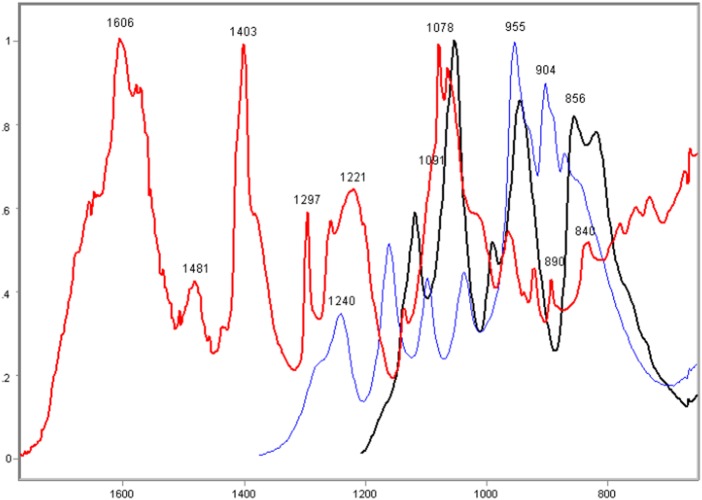
FT-IR spectral profile of calf thymus DNA compared to those of NaH2PO4, and Na2HPO4.DNA, red line; NaH2PO4, blue line; Na2HPO4, black line; X axis, wavenumbers in cm−1; Y axis, absorbances (A).